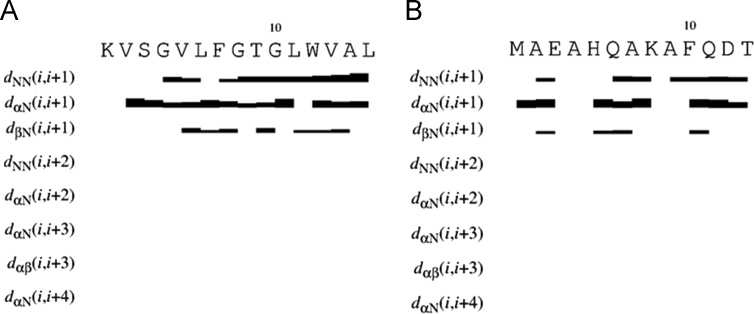
Relevant NOE contacts in DMSO for (A) MTP1 and (B) MTP2.